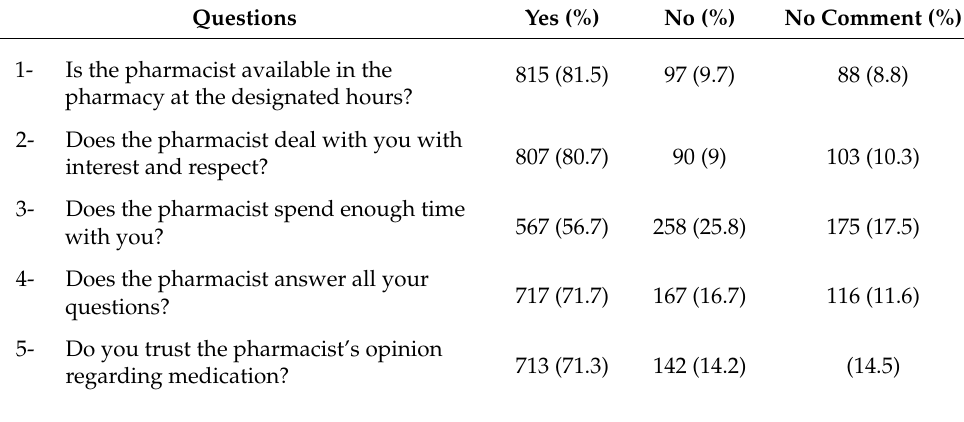
Table 3. Customers’ Views on Community